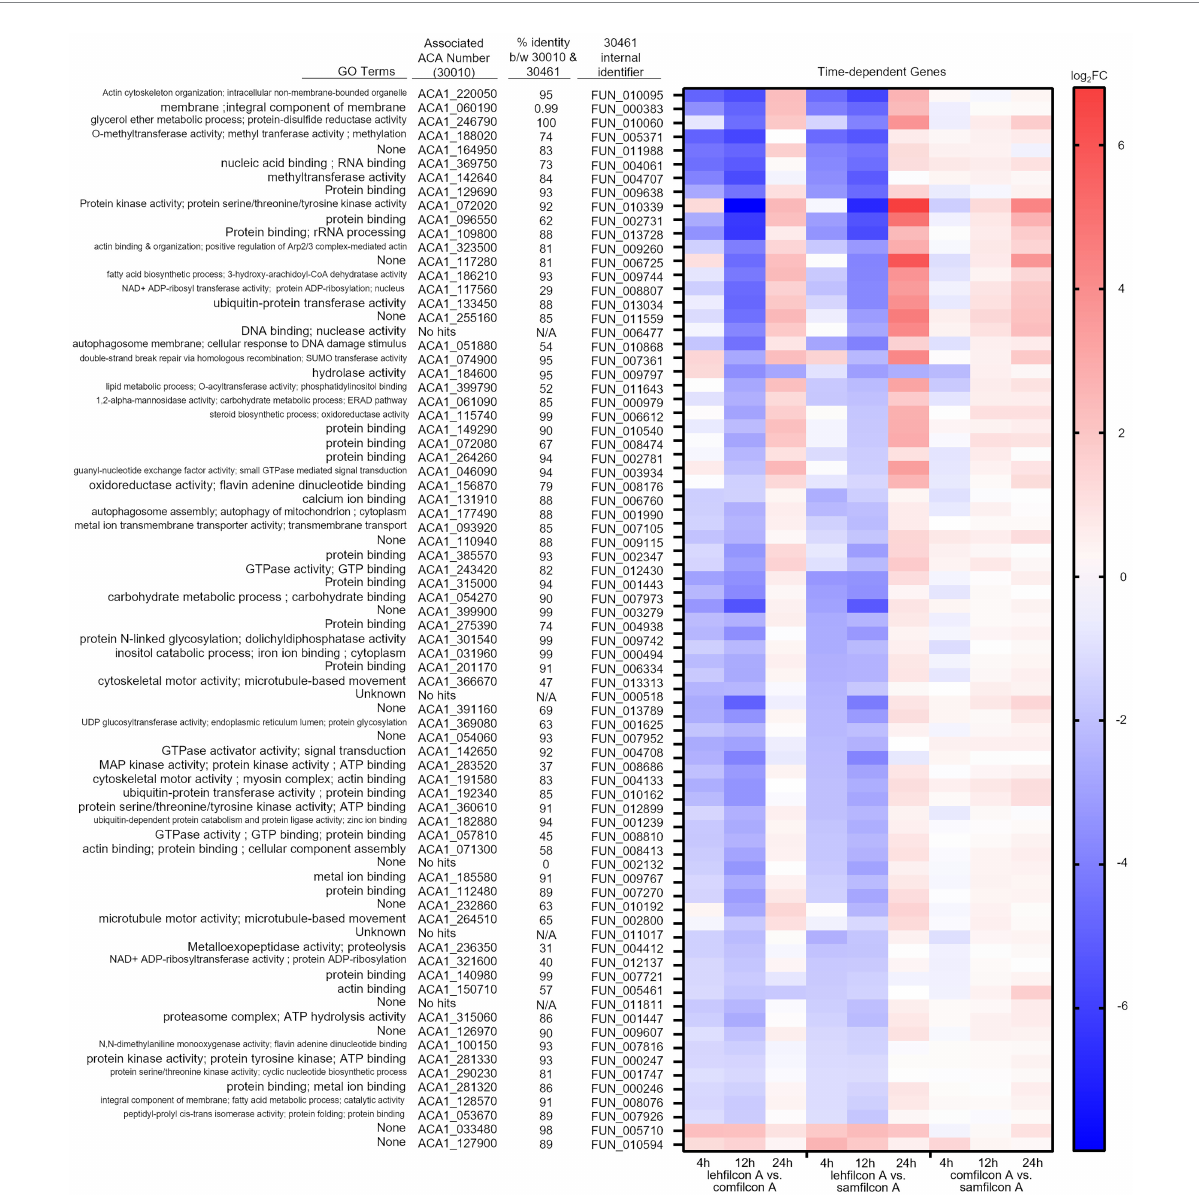
FIGURE 10 Genomic analysis of Acanthamoeba polyphaga (ATCC 30461) on three different contact lens materials at hours 4, 12, and 24. Seventy seven genes were found to be significantly differentially regulated in at least two consecutive time points; p < 0.05, n = 6 per group. Genes were clustered according to gene expression pattern with those depicted falling into a time and material-dependent expression pattern. Heat maps display the kinetics of log2 fold change in expression on lehfilcon A relative to comfilcon A (left), lehfilcon A relative to samfilcon A (middle), and comfilcon A relative to samfilcon A (right). Genes are described according to locus identifier, closest identified homologue in ATCC 30010, and GO terms associated with ATCC 30010 protein according to